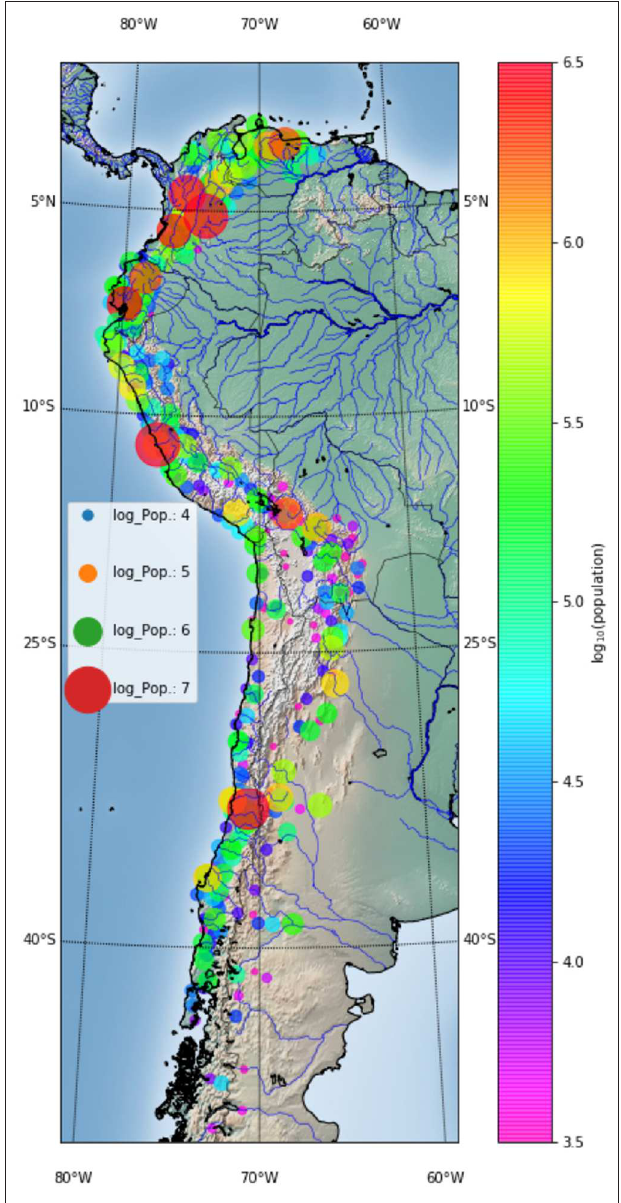
FIGURE 1 | Location and population of cities and towns along the Andes, whose populations are greater that 10,000 inhabitants. Data source: World Cities Database